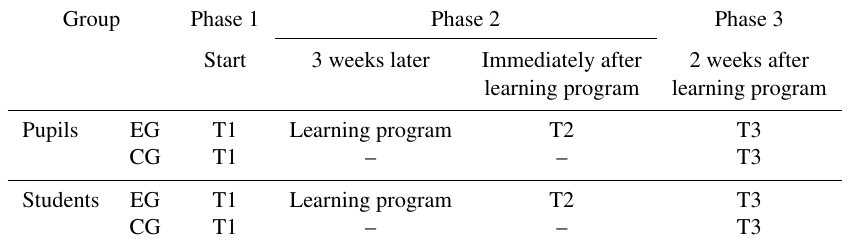
Table 2. Research plan (EG is the experimental group, CG the control group, T1 the pre-test, T2 the formative evaluation, T3 the post-test). Group Phase 1 Phase 2 Phase 3 Start 3 weeks later Immediately after 2 weeks after learning program learning program Pupils EG T1 Learning program T2 T3 CG T1 T3 Students EG T1 Learning